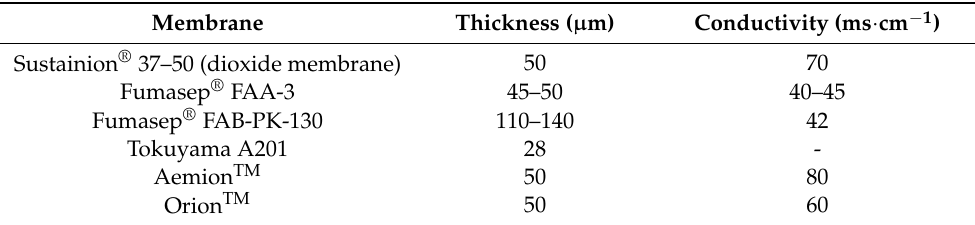
Table 2. Commercially available membranes and their properties [52,57,58]. Membrane Thickness ( µ